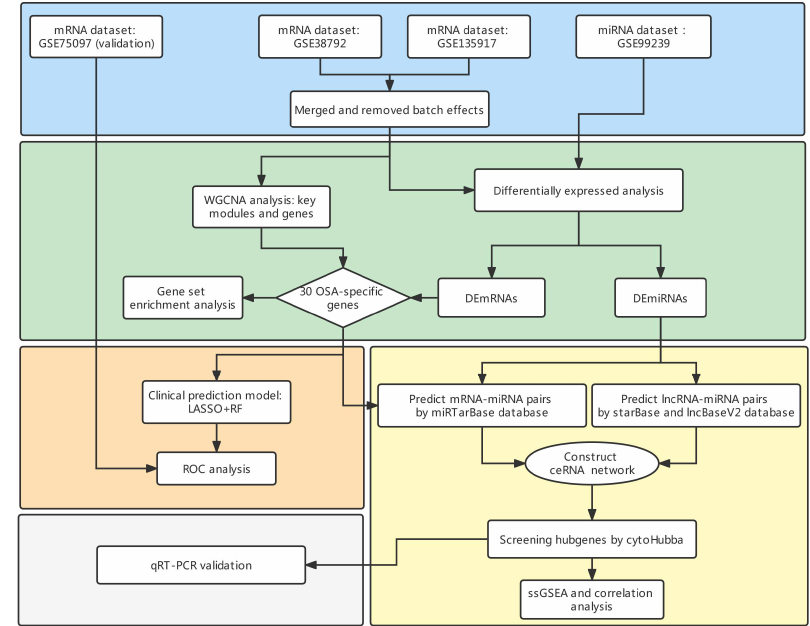
Figure 1. The flowchart of current